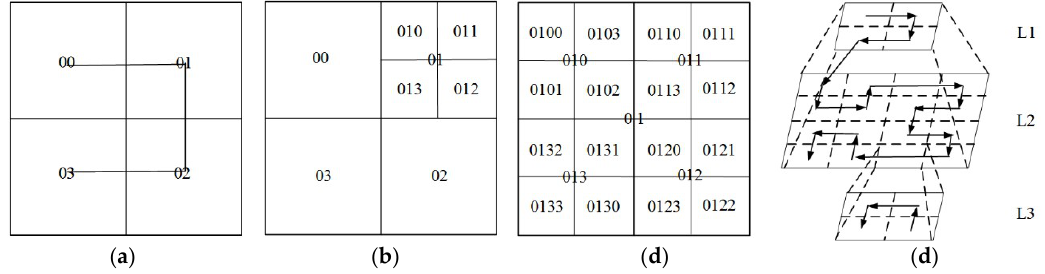
Figure 6. 2-bit strings to decimal values.